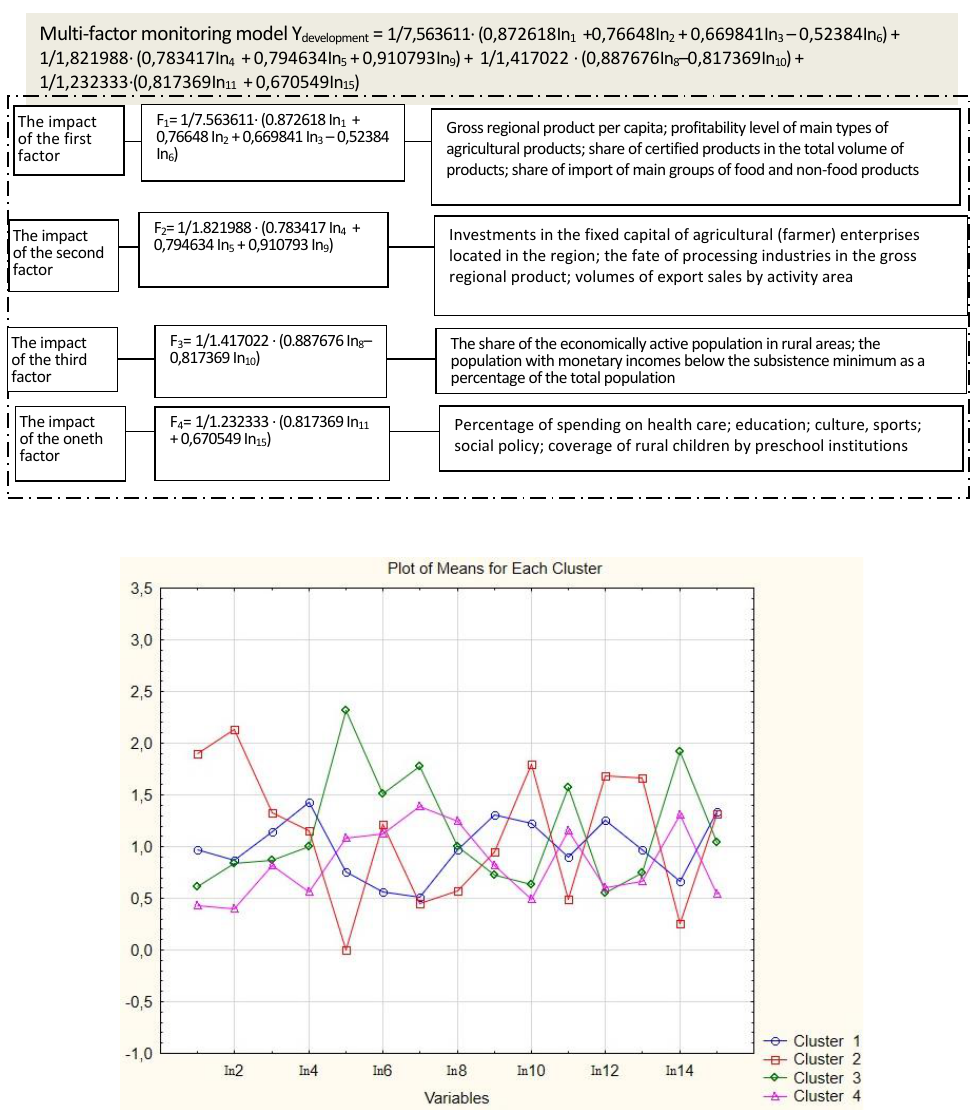
Fig. 6: Factor model of the system of monitoring the state of socio-economic development of rural areas Multi-factor monitoring model Y development = 1/7,563611∙ (0,872618In 1 +0,76648In 2 + 0,669841In 3 – 0,52384In 6 ) + 1/1,821988∙ (0,783417In 4 + 0,794634In 5 + 0,910793In 9 ) + 1/1,417022 ∙ (0,887676In 8 –0,817369In 10 ) +